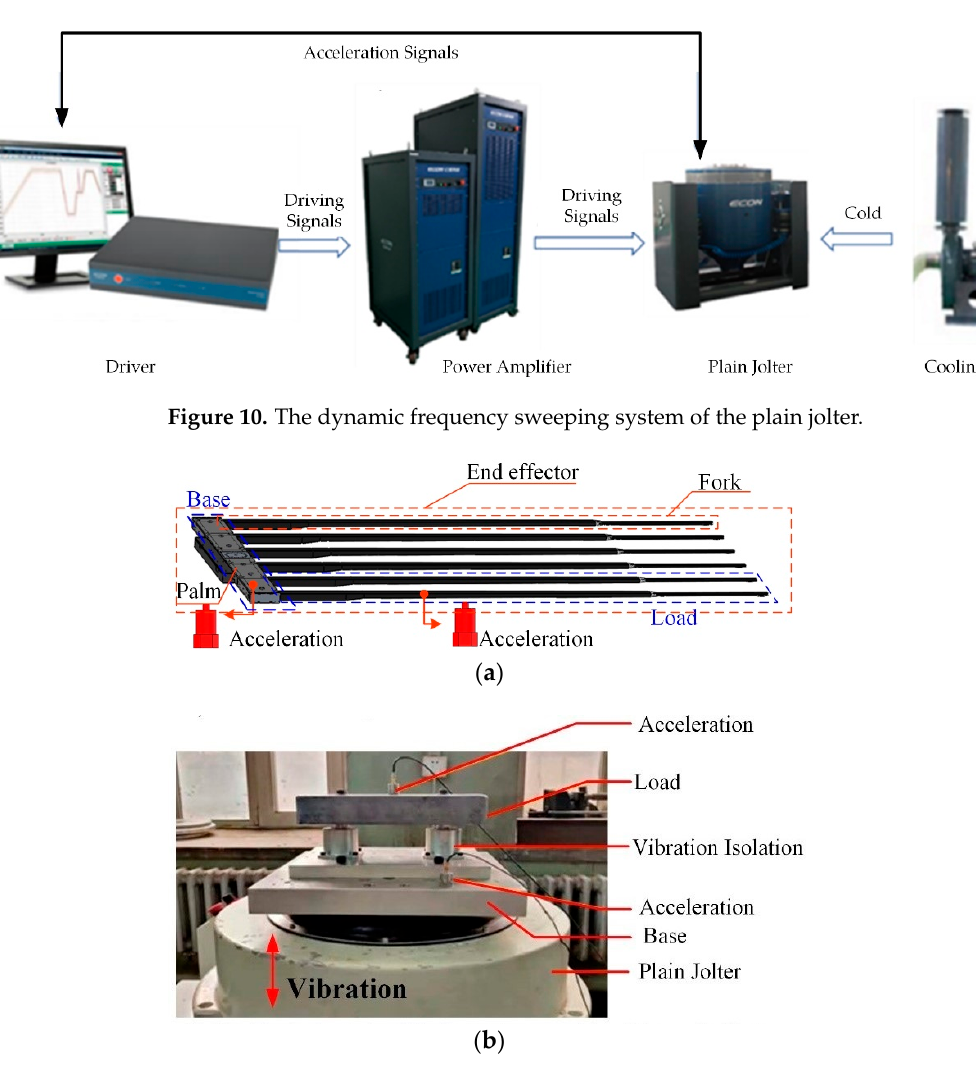
Figure 11. Dynamic frequency sweep experiment diagram. ( a ) The structure graphic of the end effector; ( b ) The equivalent simplified structure graphic of the end effector.